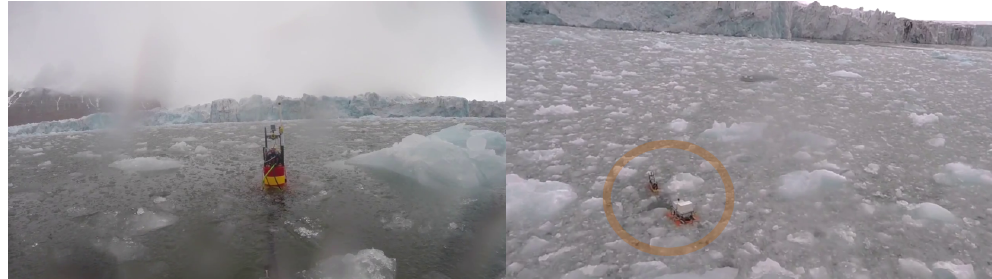
Figure 21. UVASS project: PROTEUS moving in the middle of bergy bits and growlers toward the Kronebreen and PROTEUS trapped in the ice